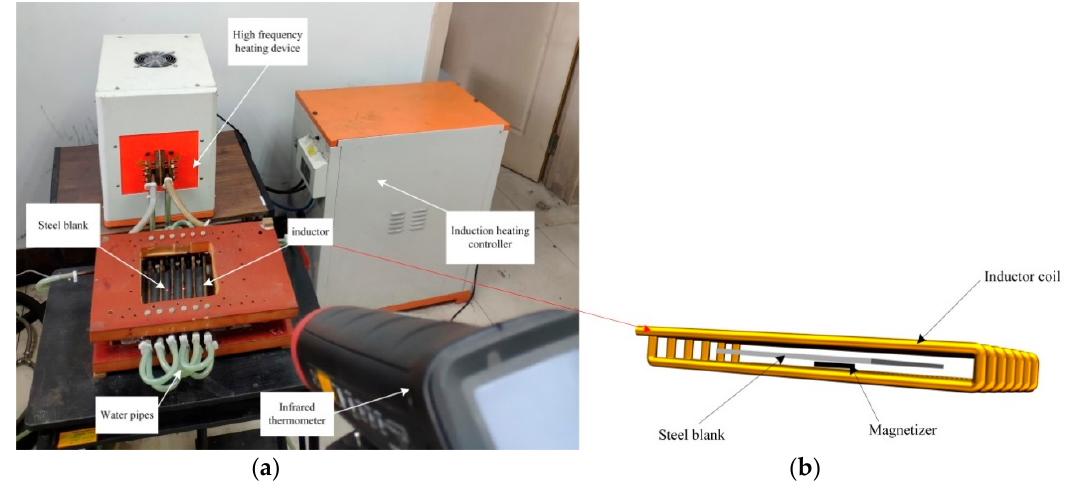
Figure 1. Localized induction heating system. ( a ) Experimental setup; and ( b ) schematic diagram of localized induction heating model.